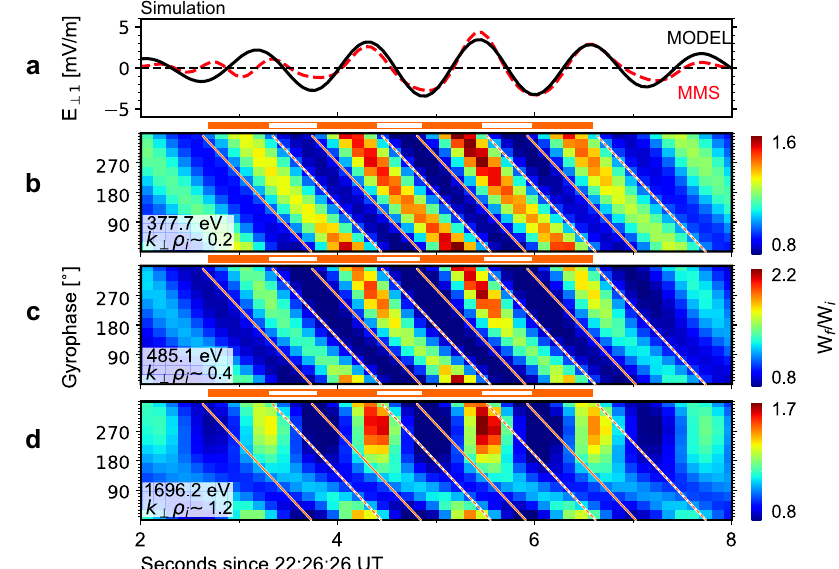
Fig.5|Phase-bunchingstripegapsreproducedinnumericalsimulations.a The modeled (black) and observed (red) electric fi elds of the KAWs. b – d The ratio between the fi nal and initial proton energy, which is a proxy for the evolution of proton phasespace densities.The orangesolid and dashed lines give the expected